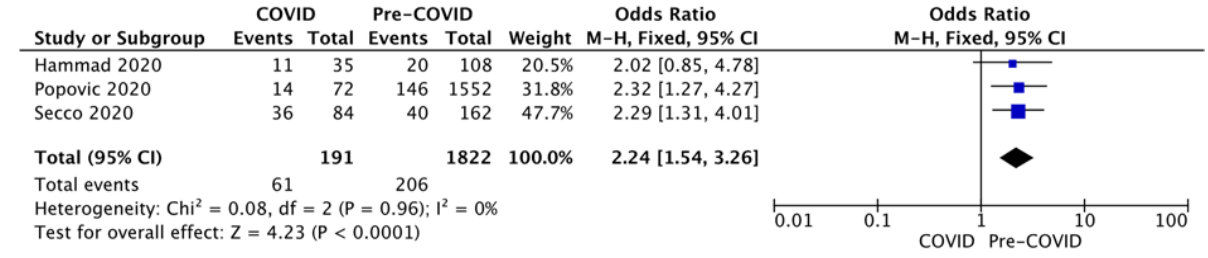
Figure 7. Forest plots for LVEF at presentation.